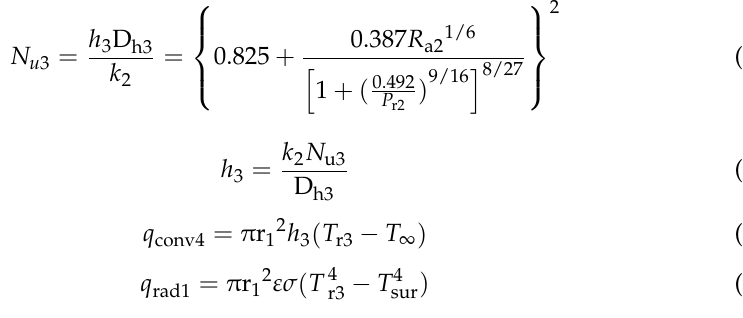
Chu [28], the Nusselt number of the cap head outer-face is given in Relation (20). Thus, the convective heat transfer coefficient h 3 could be calculated in Equation